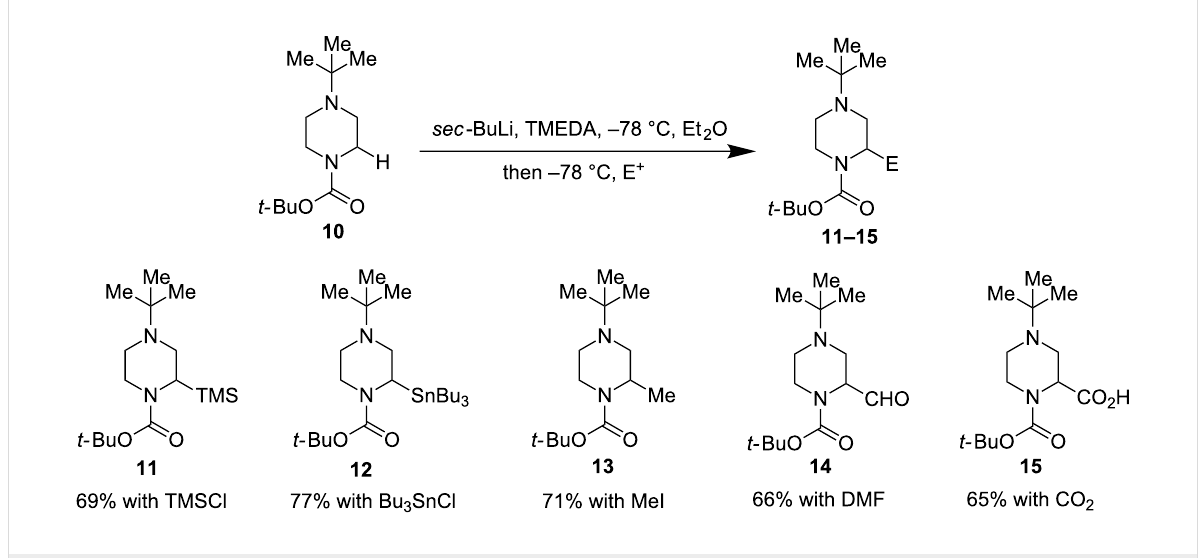
Figure 4: α -Lithiation of N -Boc- N’ - tert -butyl piperazines by Coldham et al. in 2010 [38].